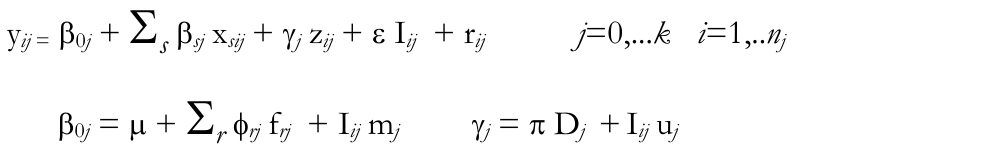
Agenti efficaci Impatto intervento